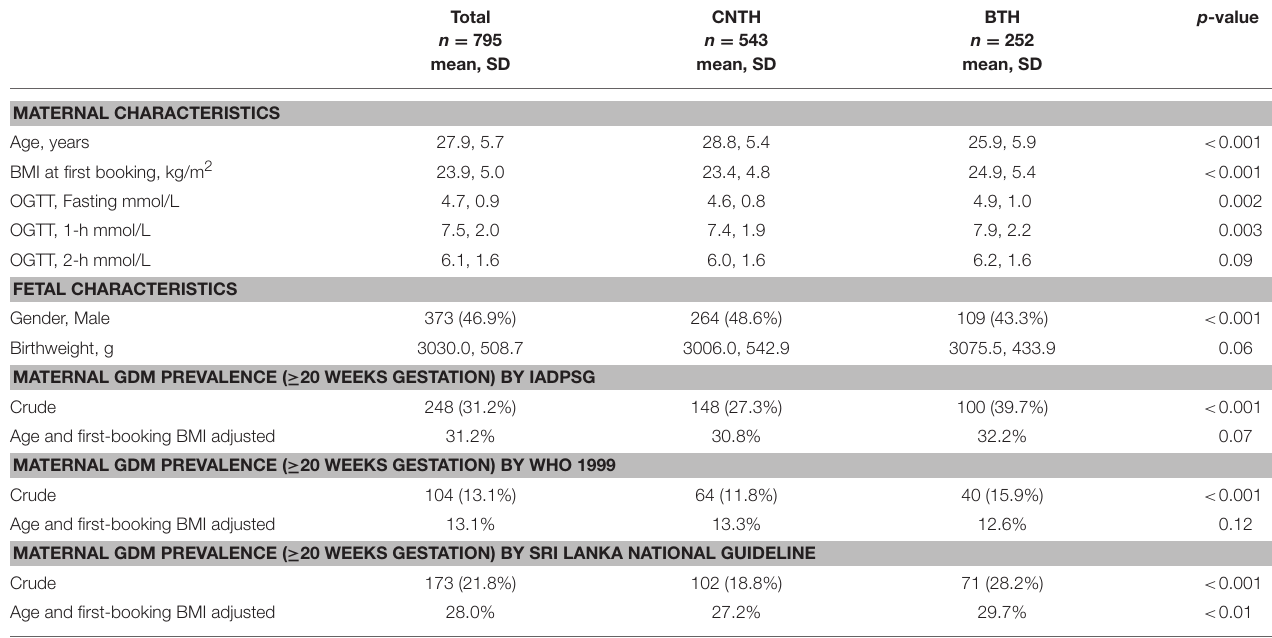
TABLE 1 | Characteristics and GDM prevalence in two Sri Lanka tertiary